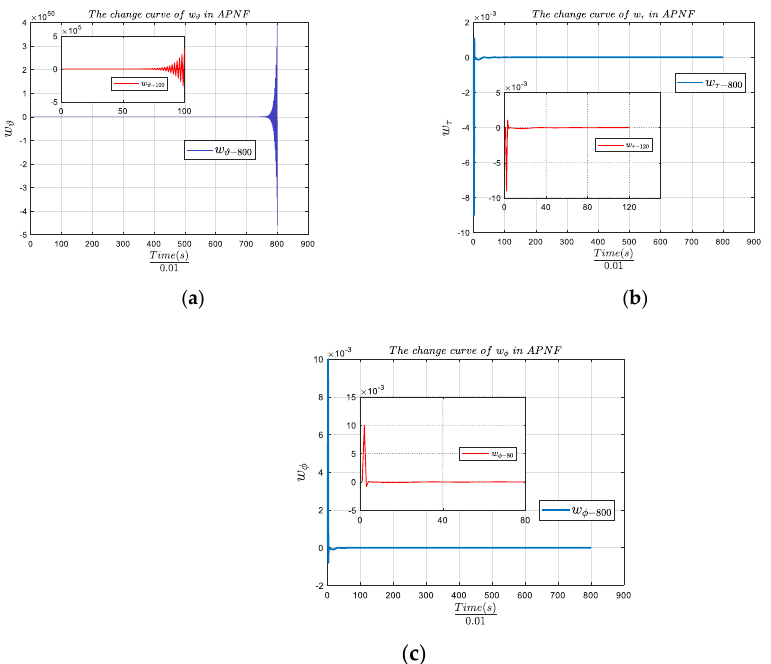
Figure 10. ( a ) Parameter change curve of 𝑤 𝜗 within 1 s and 8 s of APNF; ( b ) parameter change curve of 𝑤 𝜏 within 1.2 s and 8 s of APNF; ( c ) parameter change curve of 𝑤 𝜙 within 0.8 s and 8 s of APNF.